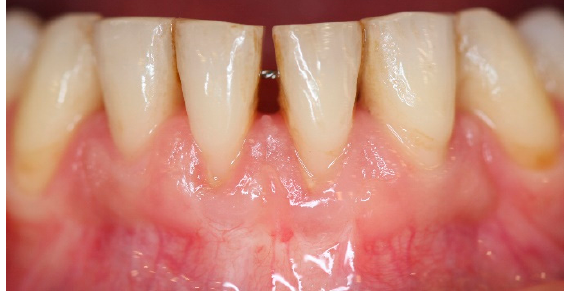
Figure 15. Three-year postoperative aspect of lower anterior area shows stable results over time.